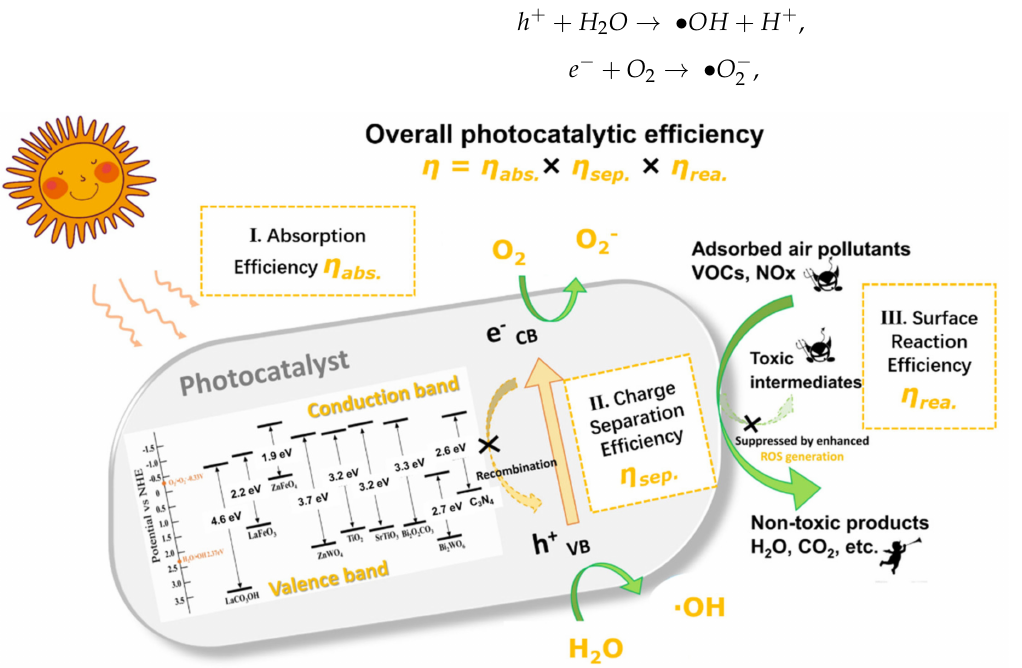
Figure 3. Scheme of environmental remediation principle by semiconductor